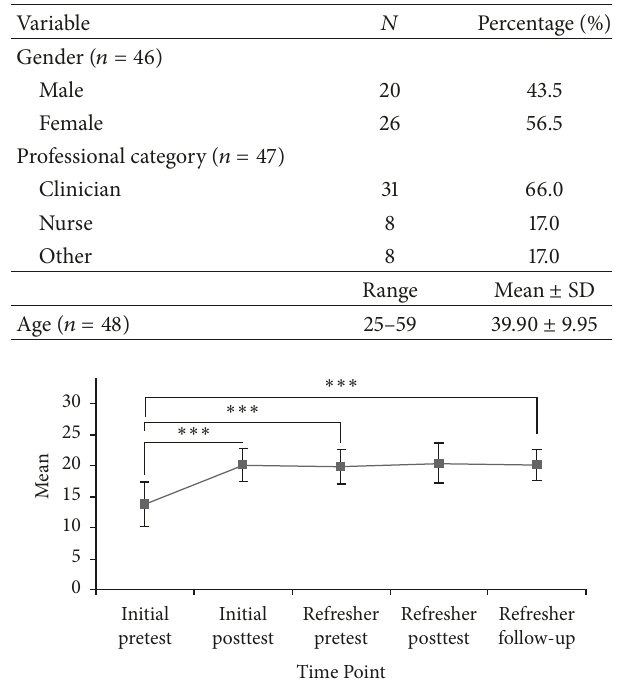
Patients identified or diagnosed with Depression over the past three months Figure 3: Healthcare practices of HCP after